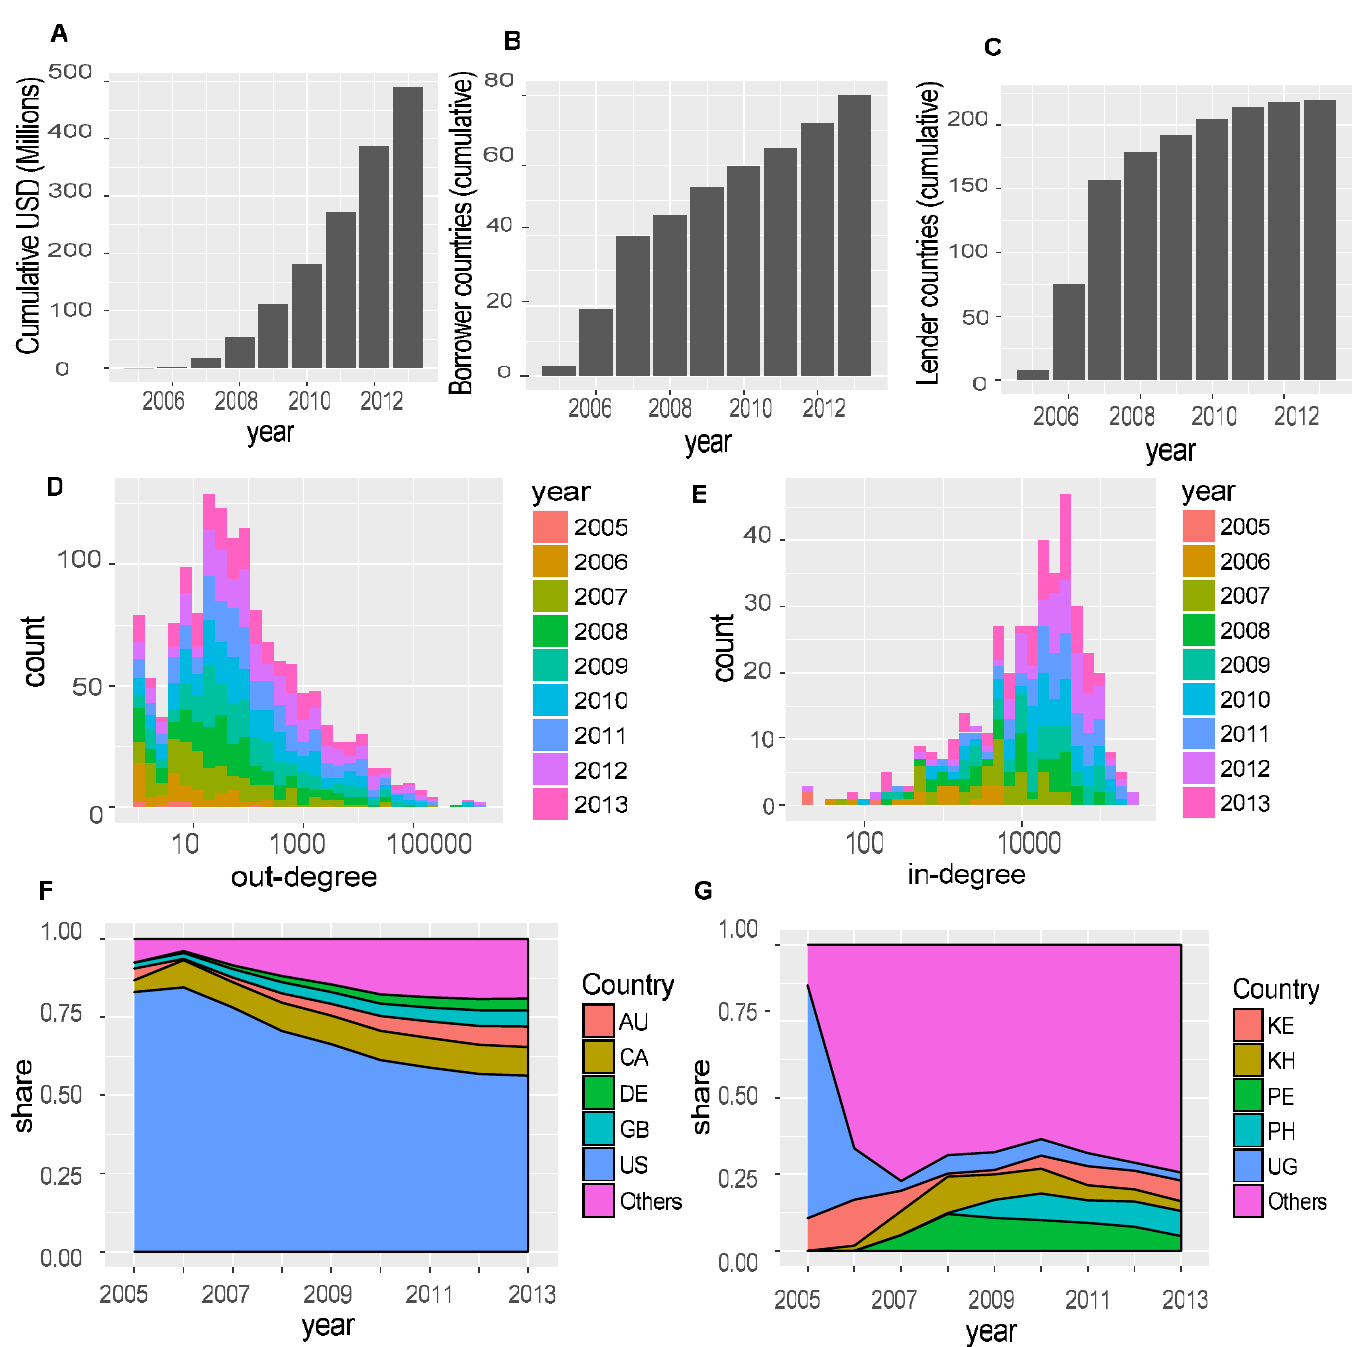
Fig 2. Evolution of the Kiva country network. (A) Total annual money lent through Kiva (cumulative). (B) Cumulative number of borrower and (C) lender countries. Plot (A)–(C) show the rapid growth of Kiva as platform for crowdfinancing both in terms of money lended and level of participation. (D) Histogram of total number of outgoing transactions from countries (out-degree) and (E) histogram of total number of incoming transactions to countries (in-degree), color stacked by year. The X-axis scale is logarithmic, thus, the histograms reflects the skewness of the distributions. (F) Top five lender countries and their share of loans given and (G) top five borrower countries for each year. The US accounts for a major share of the lending activity ( > 50%), however the US dominance is decreasing with time as we see increased participation levels from more countries.